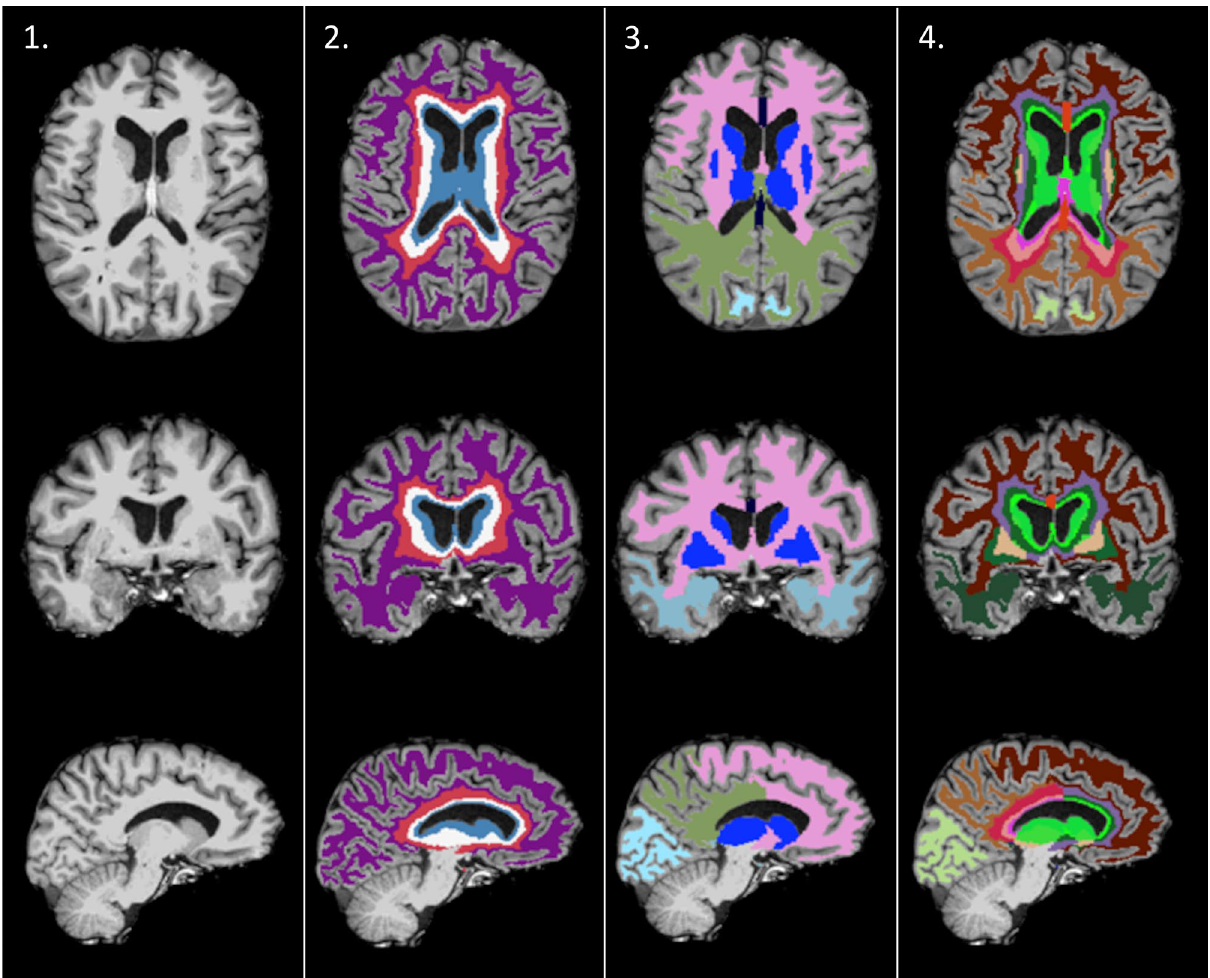
Figure 1. Bullseye parcellation of WMH. White matter from brain-extracted T1 images (1st column) was parcellated both in 4 equidistant layers representing the distance from the cortex to the ventricles (2nd column), and 9 regions representing either the lobe of each hemisphere or the basal ganglia (3rd column). Bullseye parcellation represents the intersection between these maps (4th column). This figure was constructed